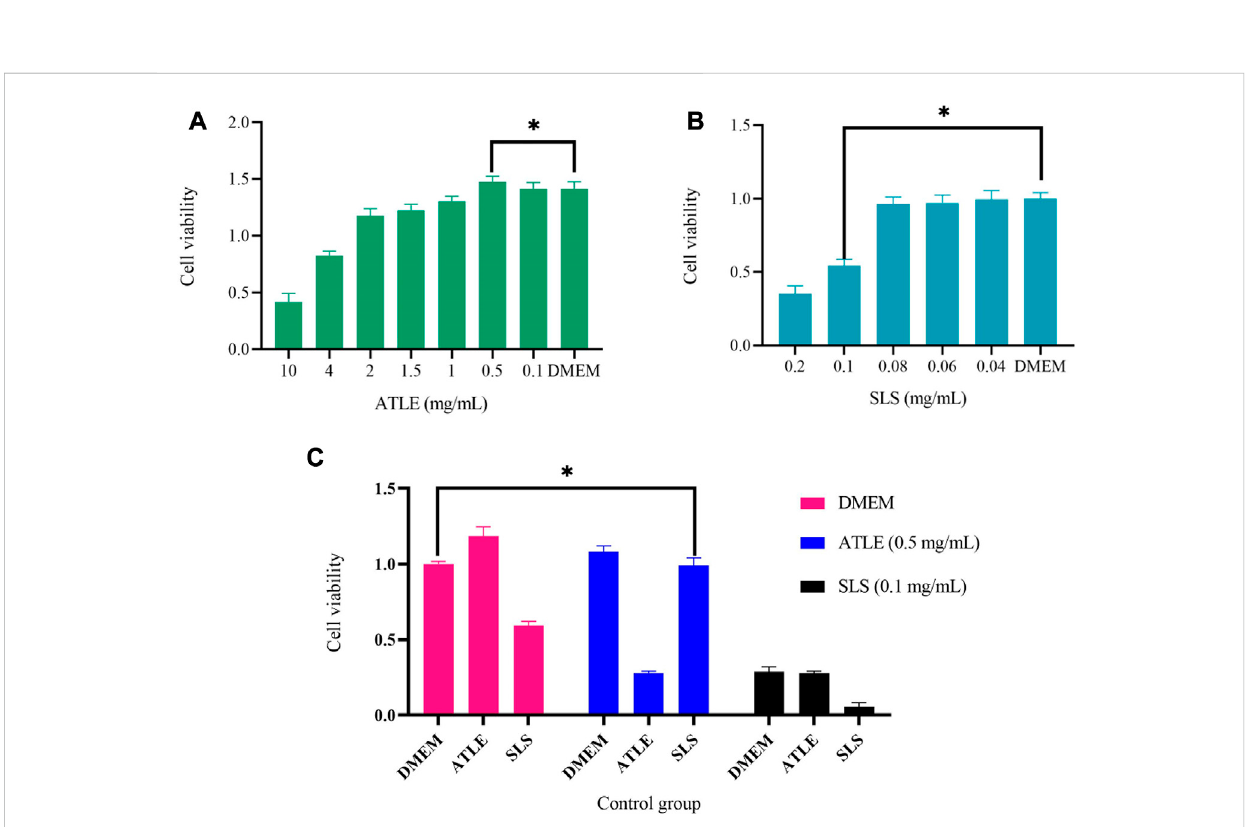
The effects of Sodium Lauryl Sulfate (SLS) and A. truncatum leaf extract (ATLE) on HaCaT cells. Cell viability was analyzed by Cell Counting Kit-8. (A) The HaCaT cells were treated with 10 – 0.1 mg/mL ATLE for 24 h (B) HaCaT cells were treated with 0.2 – 0.04 mg/mL SLS for 24 h (C) HaCaT cells were pre-treated with 0.5 mg/mL ATLE and 0.1 mg/mL SLS for 24 h with DMEM used as a negative control. * p <